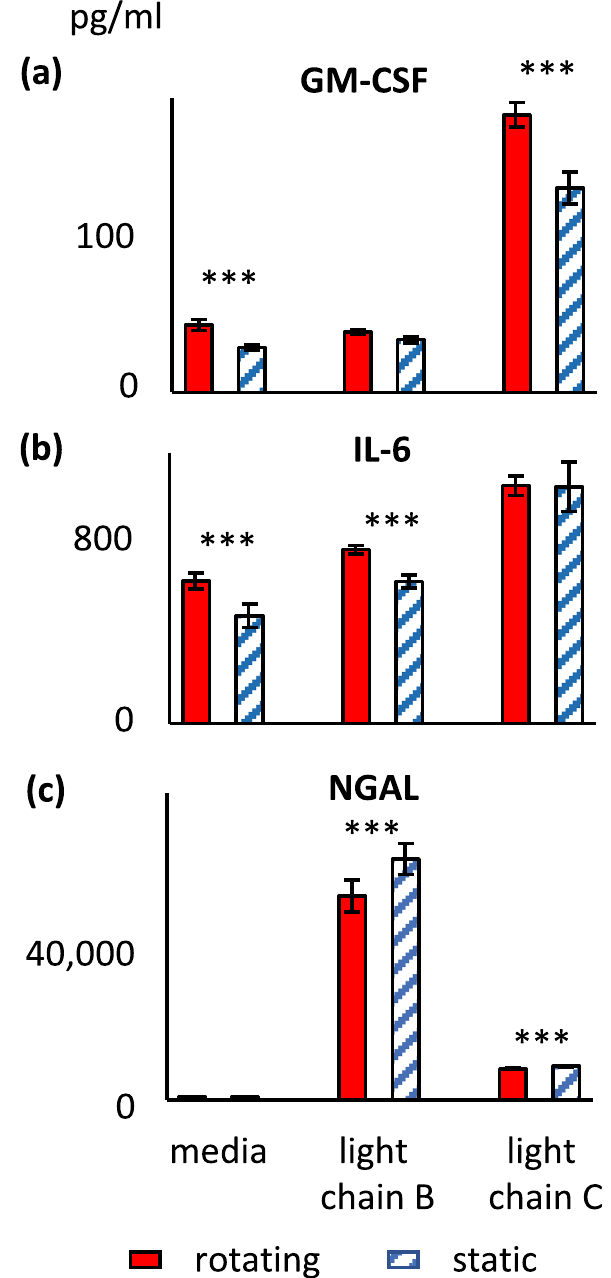
Figure 9. Effect of rotation in cell spinpods on cytokine release from renal cells. RPTEC/TERT1 cells on Cytodex carrier beads were cultured in cell spinpods under rotating conditions ( ) or static conditions ( ) in the presence of myeloma light chains from donor B, myeloma light chains from donor C, or media. After 48 h, supernatants were harvested for assay of cytokines. Bars presented mean concentration (pg/mL) of GM-CSF, panel ( a ), IL-6, panel ( b ), and NGAL panel ( c ), in the cell supernatant; error bars are ± SEM. Asterisks indicate where differences in the distributions between rotating and static groups were statistically significant, e.g. p < 0.05, by one-tailed Mann–Whitney U test. Rotation induced significantly greater quantities of GM-CSF in the media control ( p = 0.004, W = 39, n 1 = 7, n 2 = 6) and after stimulation with myeloma light chains from donor C ( p = 0.005, W = 33, n 1 = 7, n 2 = 5). Rotation induced significantly greater quantities of IL-6 after culture in media alone ( p = 0.036, W = 34, n 1 = 7, n 2 = 6) and with myeloma light chains from donor B ( p = 0.001, W = 41, n 1 = 7, n 2 = 6). Rotation significantly reduced the quantities of NGAL released after stimulation with myeloma light chains from donor C ( p = 0.024, W = 5, n 1 = 7, n 2 = 5) and myeloma light chains from donor B (Fig. 8c, p = 0.05, W = 9, n 1 = 7, n 2 =